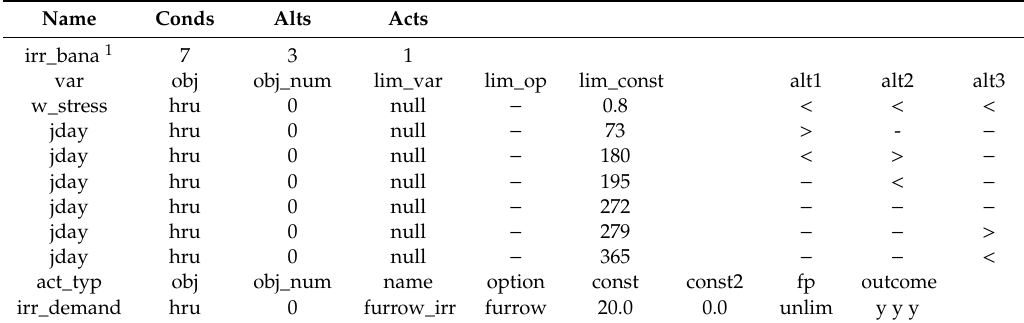
Table 6. Decision table for irrigation application in SWAT + for the irrigated banana, co ff ee, and maize